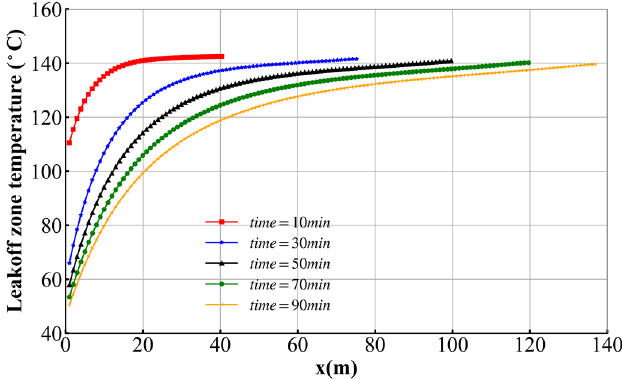
Figure 11. Temperature distribution in the leak-off zone at different times.